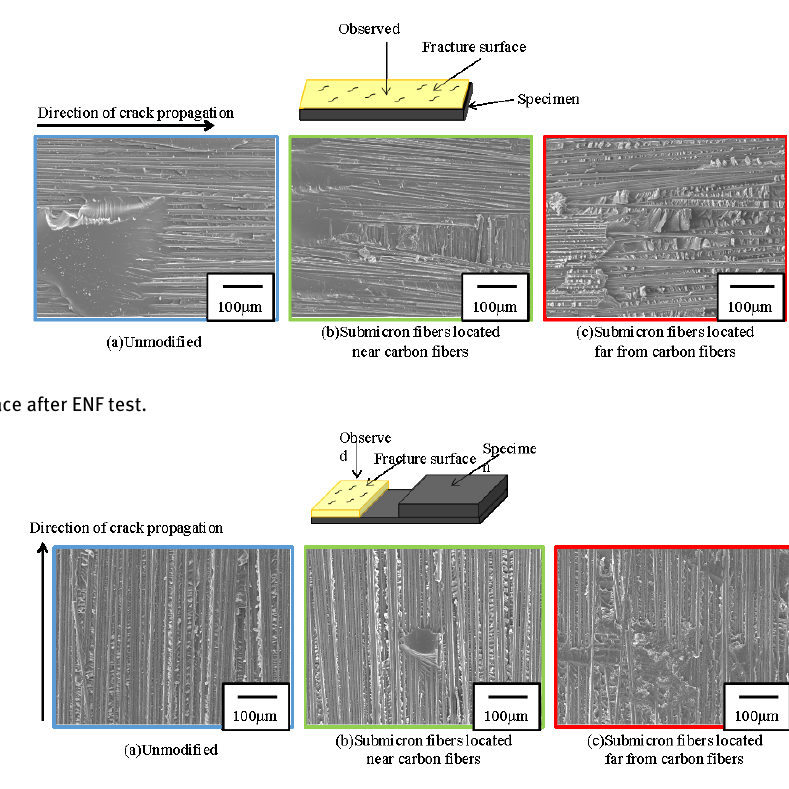
Figure 6: Fracture surface after nominal tensile shear